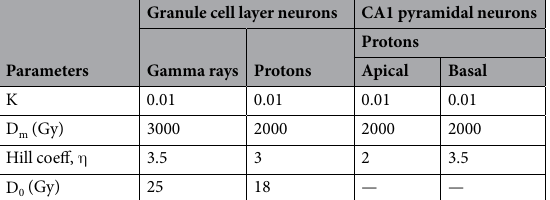
Table 1. Parameters for mouse hippocampal neurons after exposure to low-LET